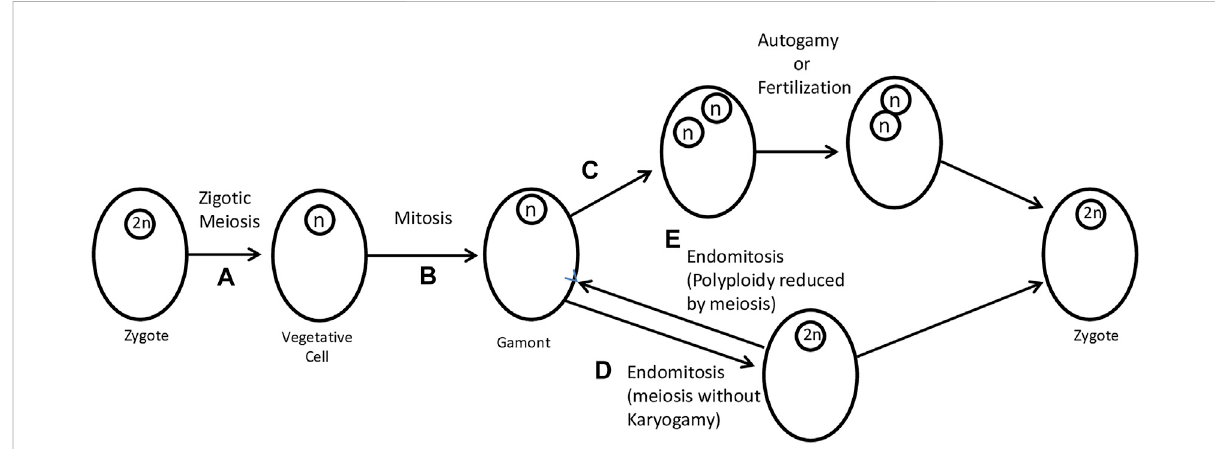
FIGURE 2 Zygotic meiosis and its modi fi cations in sexual reproduction. (A) The zygote divides by meiosis to produce a vegetative cell. (B) Gamonts are produced by mitosis of vegetative cells. (C) A coenocytic-like division can produce two haploid nuclei that, by autogamy, produce a zygote. In this case,themodi fi cationliesintheomissionofcelldivision(alsoknownasendomitosis).Autogamy andfertilization canproduceazygote. (D) Afurther simpli fi cation (which can scarcely still be considered “ normal ” ) consists in the total omission of nuclear division. What remains is the reduplication of chromosomes without spindle formation, characterizing a case of endomitosis. Endomitosis allows the formation of a diploid cell. (E) Through (reverse) endomitosis, it is also possible to reduce polyploidy. Figure adapted from Grell